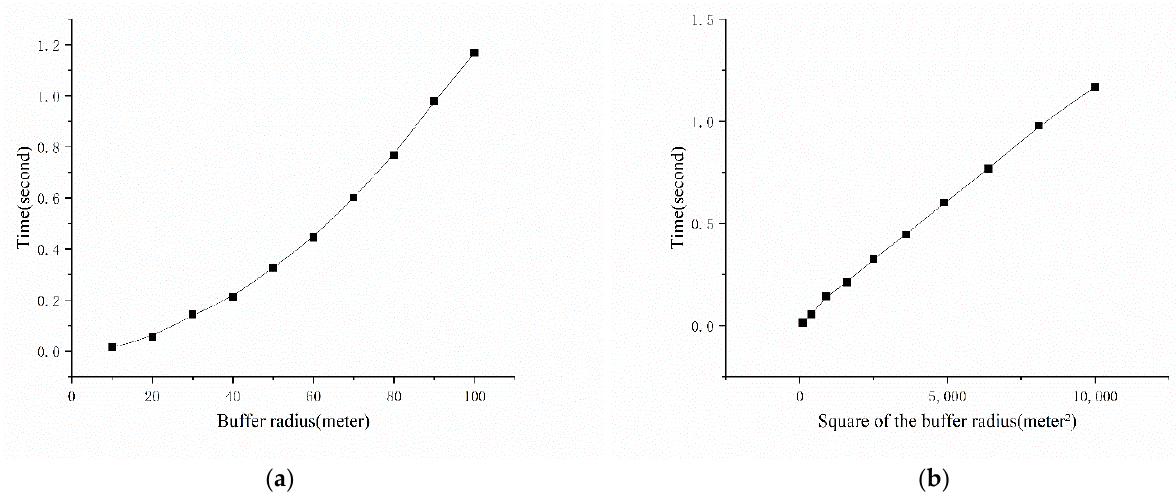
Figure 12. Algorithm efficiency diagrams for a 3D buffer of a point: ( a ) The X-axis represents the buffer radius, and the Y- axis represents the computation time. ( b ) The X-axis represents the square of the buffer radius, and the Y-axis represents the computation time.